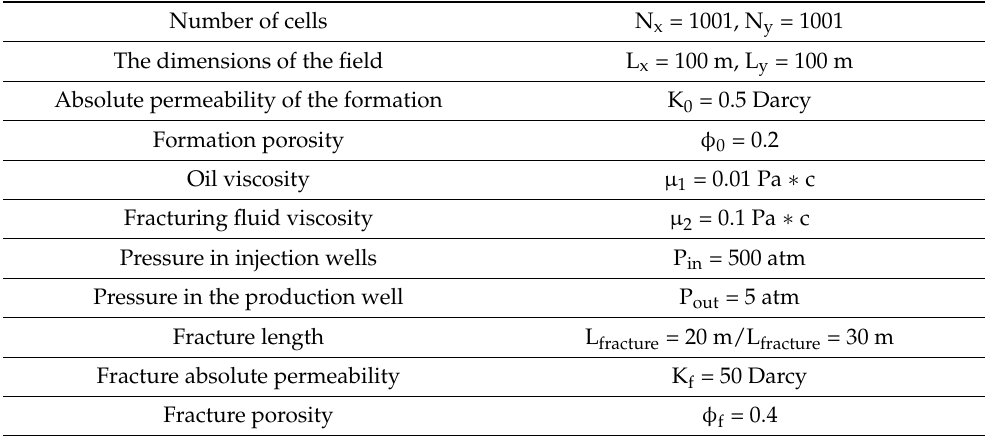
Table 3. Calculation parameters for the first numerical experiment with different fracture lengths. Number of